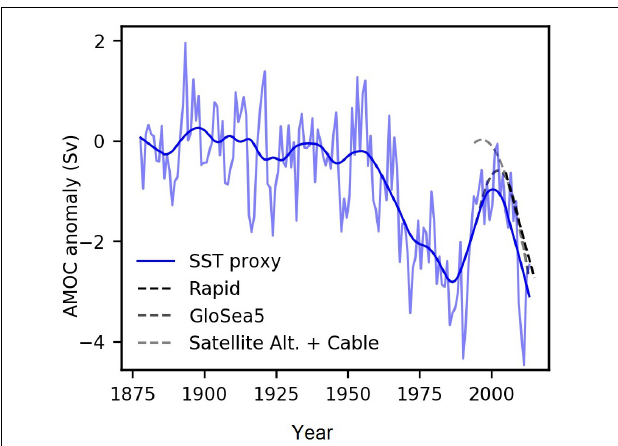
FIGURE 8 | Trend of the strength of the overturning circulation (AMOC) in observations. Shown are (i) the long-term (20-year LOWESS filtering, thin line are annual values) sea surface temperature proxy (blue), (ii) the quadratic trend of an ocean reanalysis product (GloSea5; Jackson et al., 2016), (iii) a reconstruction from satellite altimetry and cable measurements (Frajka-Williams, 2015) and (iv) the linear trend of in situ AMOC monitoring by the RAPID project. Figure from Caesar et al.